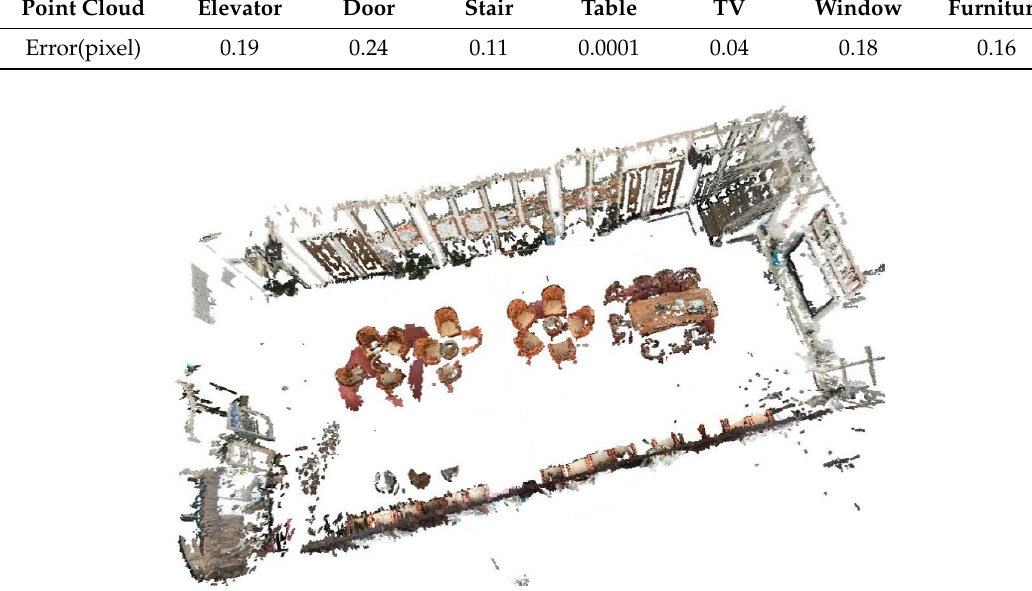
Figure 5. The reconstructed model of the meeting room. Table 3. The registration error.